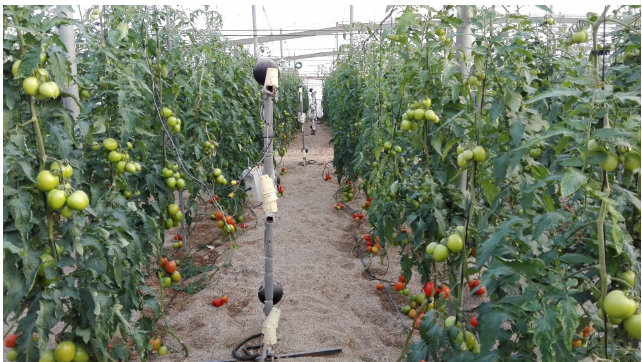
Figure 8. Image of the greenhouse on November 2018, when the tomato crop reached around 2.20 m high.